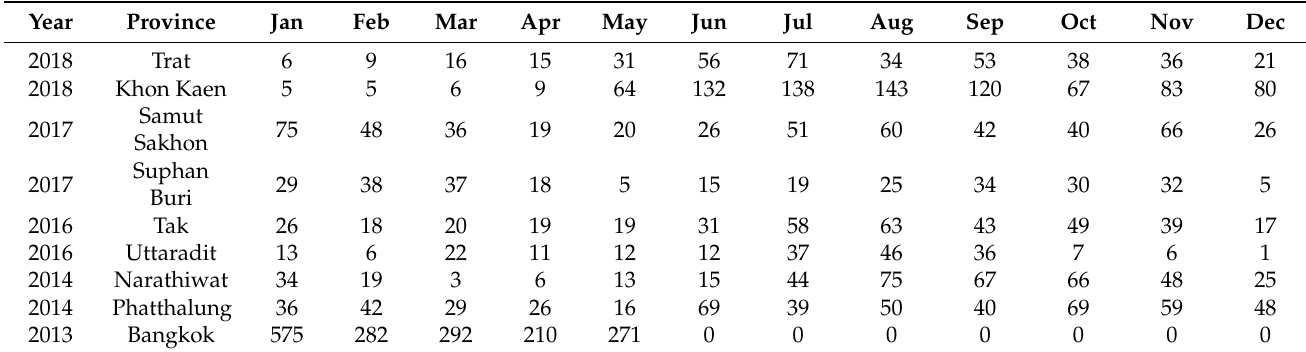
Table 3. Month category report from the dengue fever dataset.